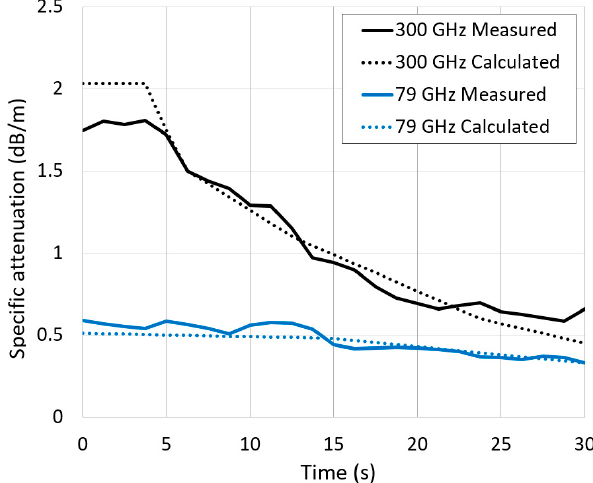
Figure 10. Radar signal measured and calculated specific attenuation in steam versus time.